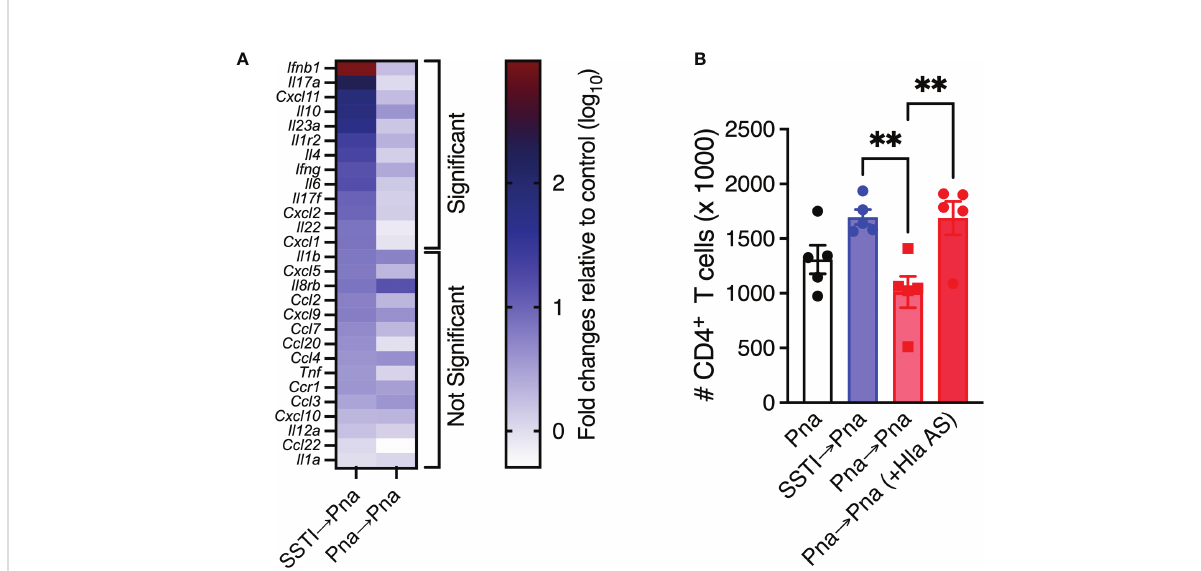
FIGURE 5 Priming by SSTI permits early in fl ammation and T cell expansion in the lungs during secondary pneumonia. (A) Heat map of in fl ammatory gene expression quanti fi ed by qRT-PCR on lung homogenates 42 hours following secondary pneumonia. Results are expressed as fold differences (log 10 transformed) compared with sham-infected mice using the DD Ct method. Mice that were primed with SSTI prior to secondary pneumonia (SSTI ! Pna) had signi fi cantly higher expression of 13 in fl ammatory genes, including chemokines and cytokines, compared with those that were primed with pneumonia (Pna ! Pna). There were no signi fi cant differences in the expression of 15 in fl ammatory genes. (B) Passive transfer of Hla-speci fi c antiserum (AS) prior to secondary pneumonia rescued CD4 + T cell numbers in the lungs early (42 hours) following inoculation. N=5 mice/group from one representative experiment; each experiment was performed at least twice. All data are presented as mean ± SEM. Data were compared using the Holm-Sidak method for multiple comparisons (A) or one-way ANOVA on log 10 -transformed values with Tukey ’ s post- test (B) . ** indicates p <0.01, NS indicates not signi fi